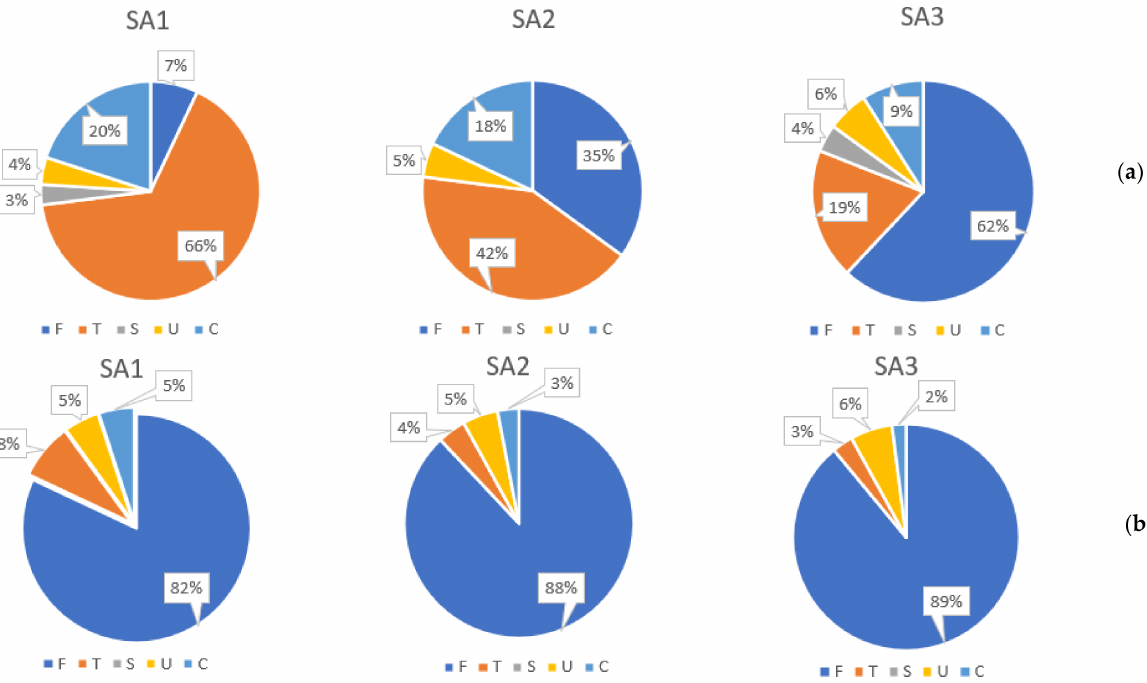
Figure 4. Variation of the number of km covered according to the type of road (F: asphalted, T: poorly asphalted or non-asphalted, S: right of way, U: urban roads, C: roads), both pre-LC ( a ) and post-LC ( b ) for each